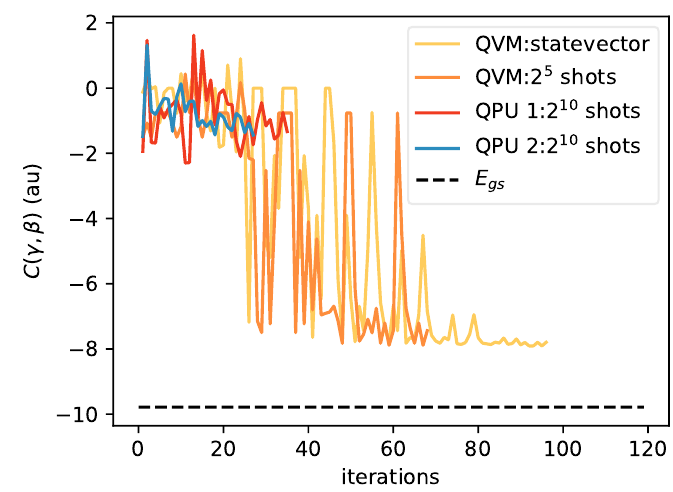
Figure 1: One instance of convergence behaviour for the QAOA optimization routines run on an exact statevector simulator, shot-noise simulator with 2 5 = 32 shots, and two 5-qubit IBM Q processors: ibmq_london (QPU 1) and ibmq_athens (QPU 2) with 2 10 = 1024 shots each. The problem in question has 5 binary variables mapped to 5 qubits and is done for a QAOA depth of p = 1. All C ( γ , β ) values dealing with shot-noise (QVM and QPU) are approximate in nature. For comparison, we include the exact ground state energy. The data in the figure is a result of the experiments described in Sections 3.3.2 and